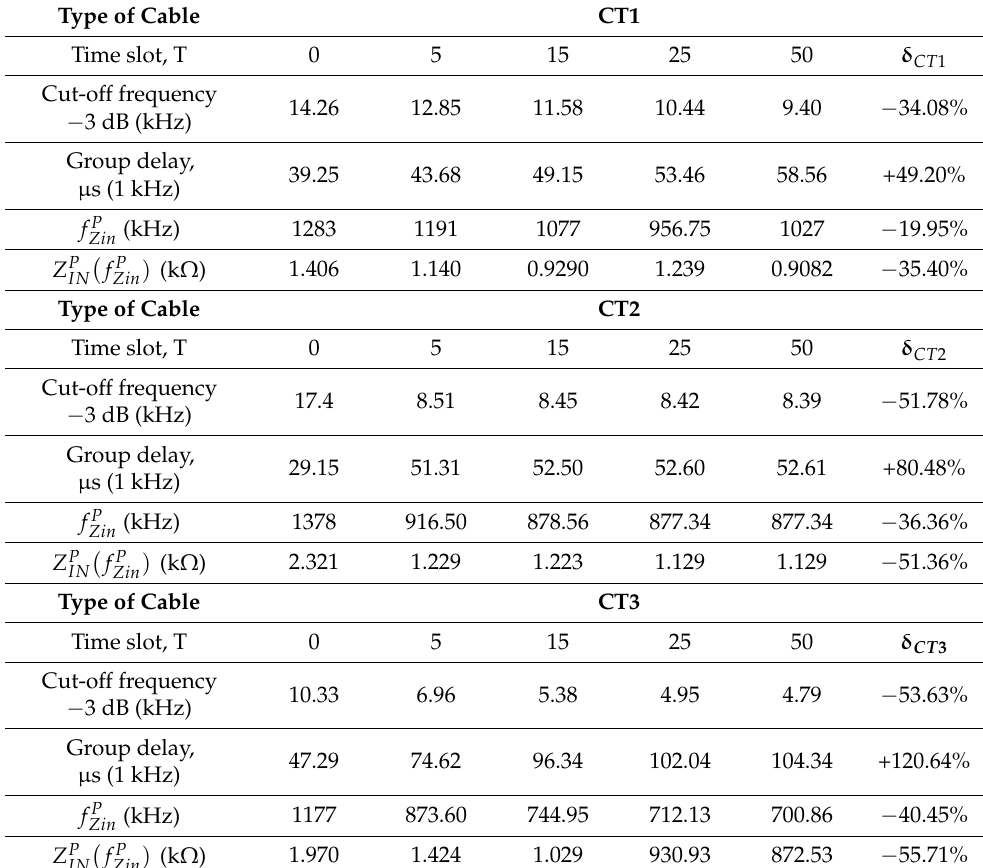
Figure 11. Frequency ( a ) and group delay ( b ) characteristics of the type 3 cable—CT3 (green, 0 T; blue, 5 T; and red, 50 T). Table 7. Impact of degradation on the communication parameters of cables (constant length l = 2.5